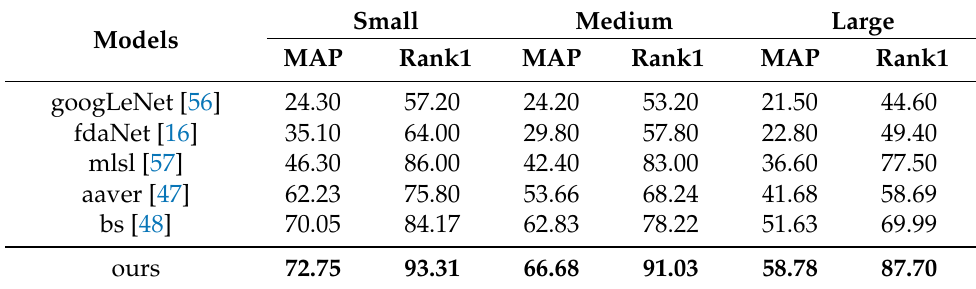
Table 5. Test on VERI-Wild (%).